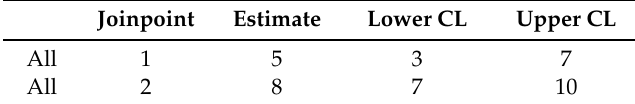
Table 3. Estimated joinpoints with corresponding confidence limits (CL).